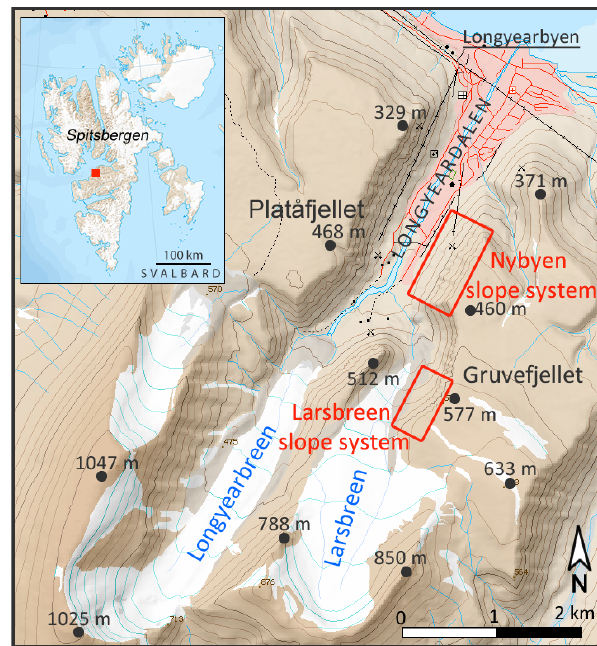
Fig. 1. Topographic map of the location of the two slope systems (red boxes) in the valley Longyeardalen in central Spitsbergen (inset map). Svalbard’s main settlement, Longyearbyen, is located at the northern end of Longyeardalen. Note the large summit plateau of Gruvefjellet